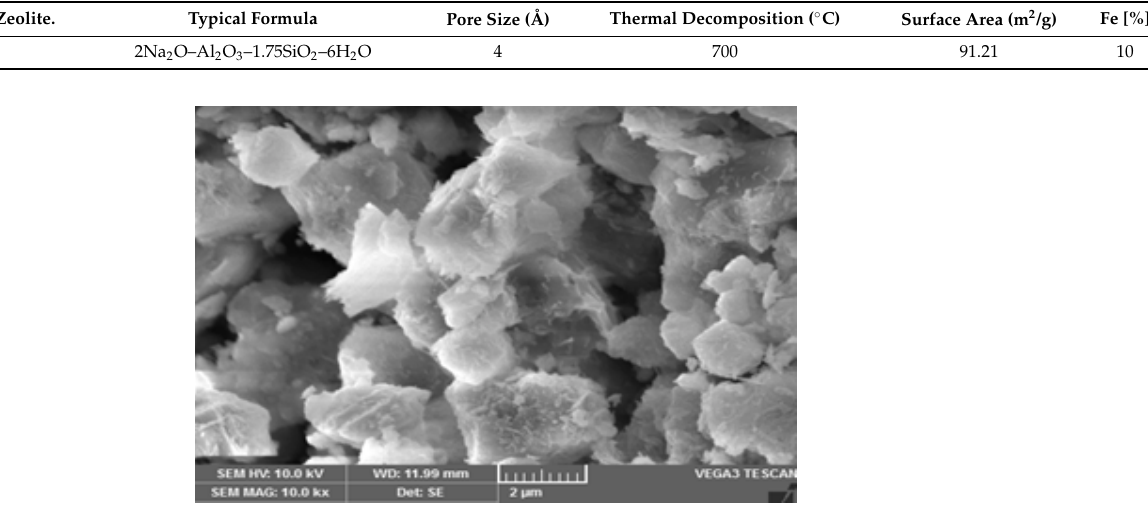
Figure 2. Energy-dispersive X-ray spectroscopy (EDX) of Fe-Zeolite ( a ) and zeolite without iron coating ( b ). Table 1. Properties of Fe-Zeolite. Properties of Zeolite.